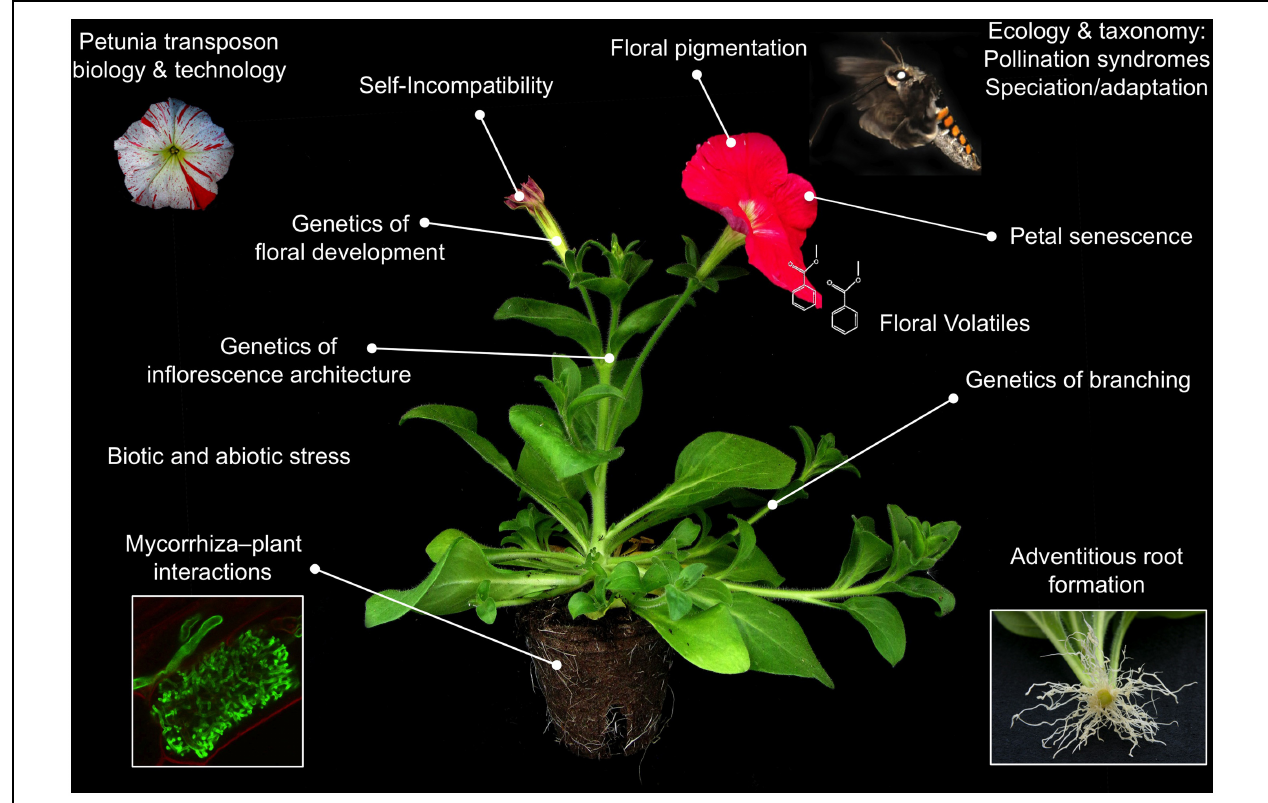
FIGURE 3 | Overview of popular petunia research